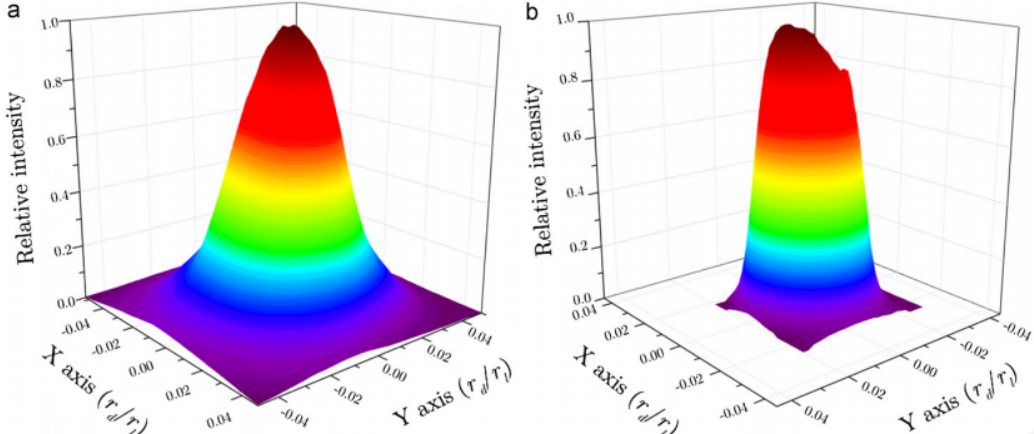
Figure 8. Flux distribution on the solar cell ( a ) using the simple Fresnel lens and ( b ) using the Fresnel lens doublet. The x and y axes are the gradationson each side of the cell, and the z axis represents the normalized intensity of the flux in the case of the simple form. Reprinted from F. Languy et al., Performance of solar concentrator made of an achromatic Fresnel doublet measured with a continuous solar simulator and comparison with a singlet. Solar Energy Materials and Solar Cells, 2013, 70–76, with permission from